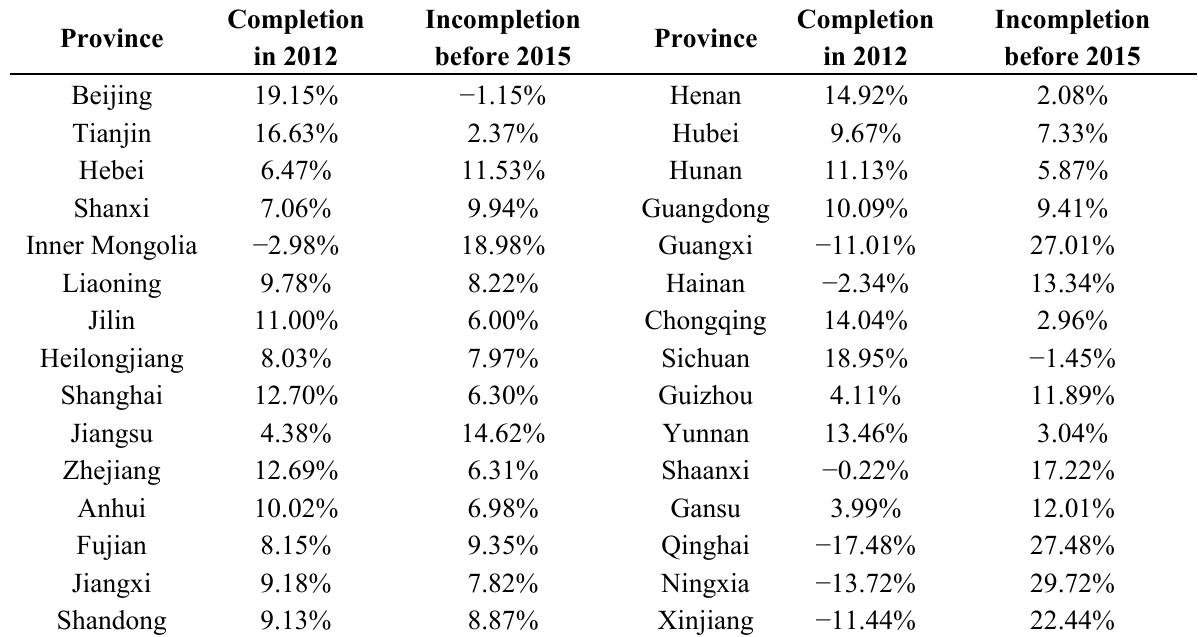
Table 4. Provincial completion of reduction plan in 2012 and incompletion before